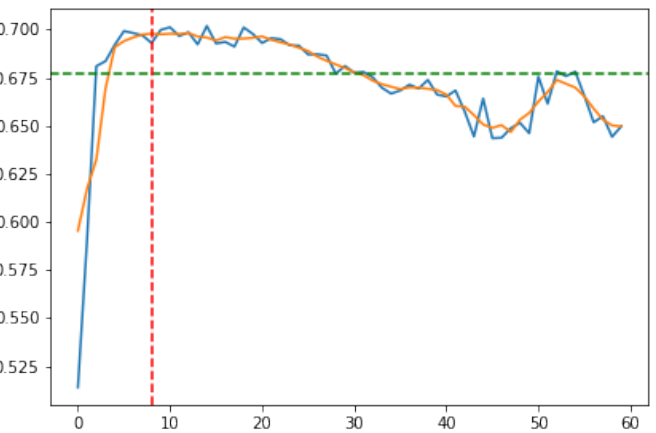
Figure 6. The accuracy of a model trained during the sequential forward selection (blue), smoothed accuracy (orange), accuracy averaged over the series excluding the segment of significant increase (green), identified iteration (red).